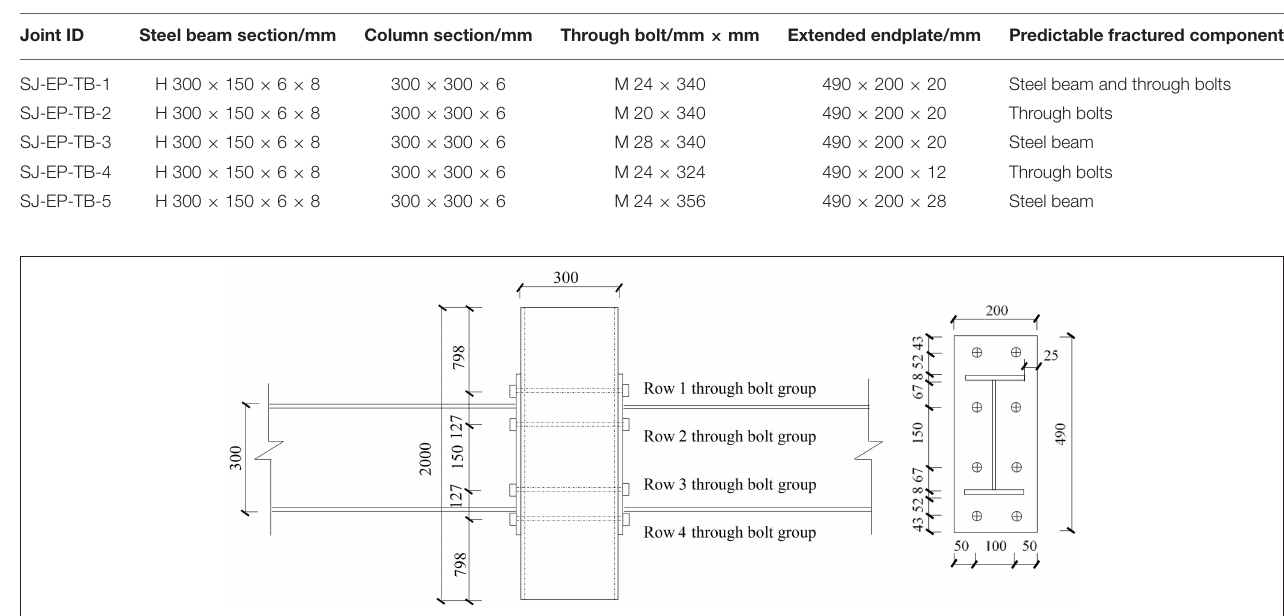
TABLE 1 | Parameters of joints.